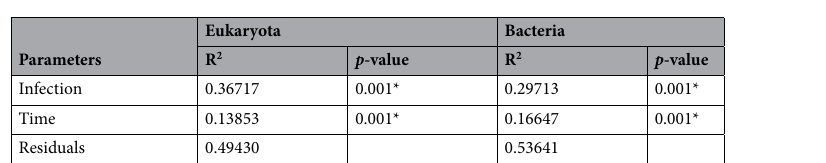
Figure 4. Nonmetric dimensional scaling (NMDS) based on euclidean distances of bacterial and eucaryotic protein group (PG) abundances. S. vauolatus cultures with aphelid infection (AI, brown) and without aphelid infection (NI, green) are denoted at the start of incubation (filled circle), after 4 (filled triangle) and 7 (filled square) days post inoculation (DPI) 54 . Ordination stresses are indicated.